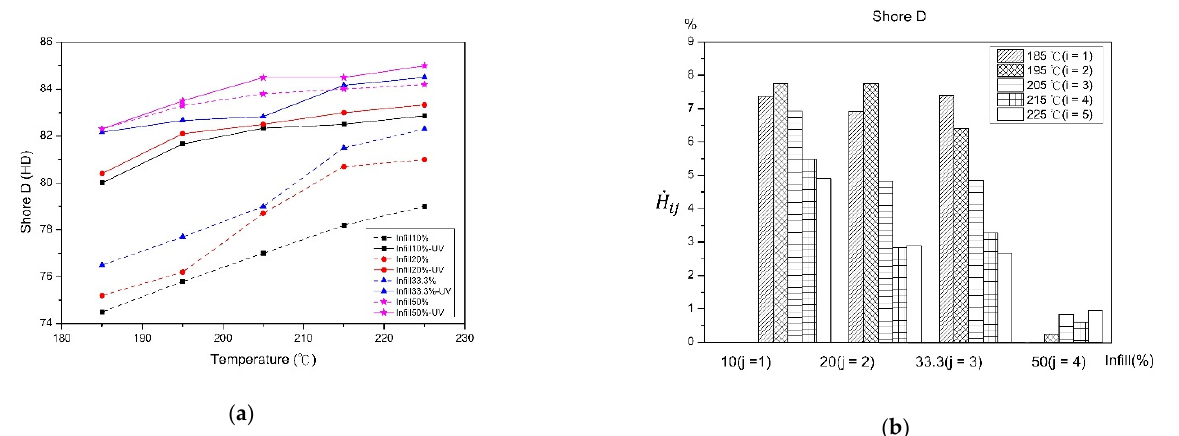
Figure 6. Before and after UV curing ( a ) hardness and ( b ) the rate of change.